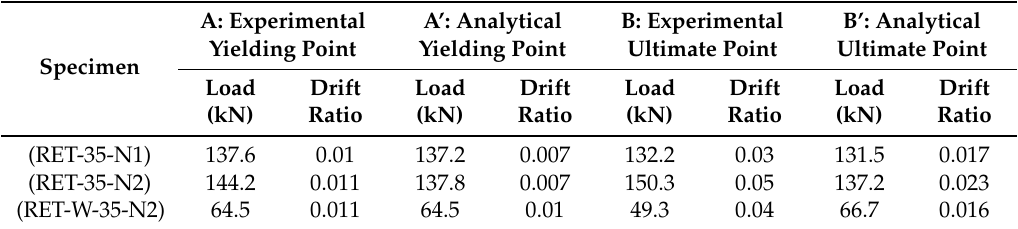
Table 11. Yielding and ultimate load-drift ratio data for the experimental and analytical results (Hany et al.